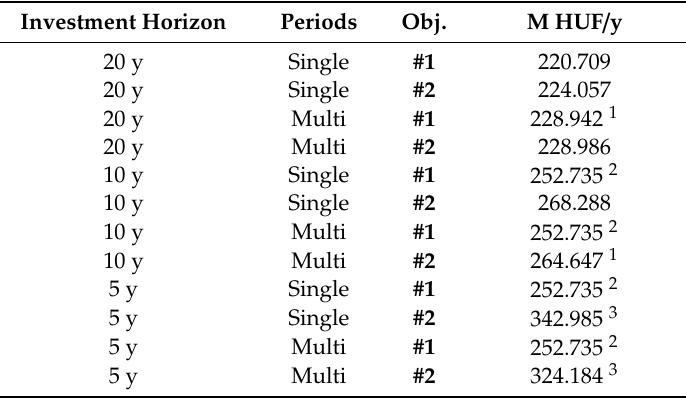
Table 12. Results for di ff erent investment horizons. Investment Horizon Periods